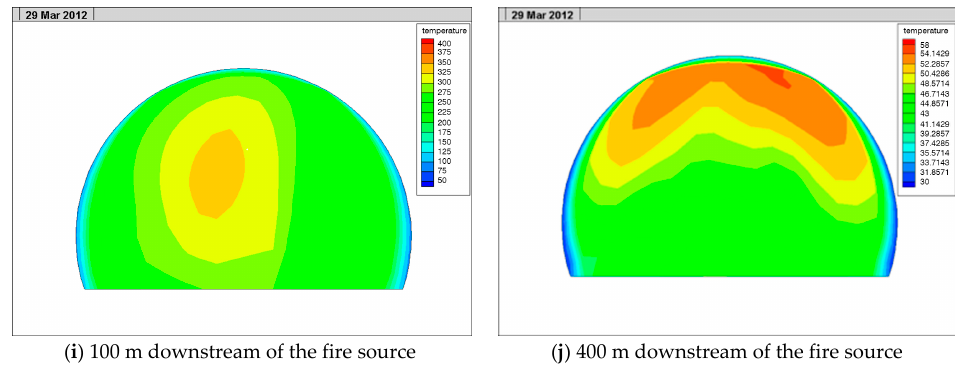
Figure 12. Cross section temperature in the tunnel.